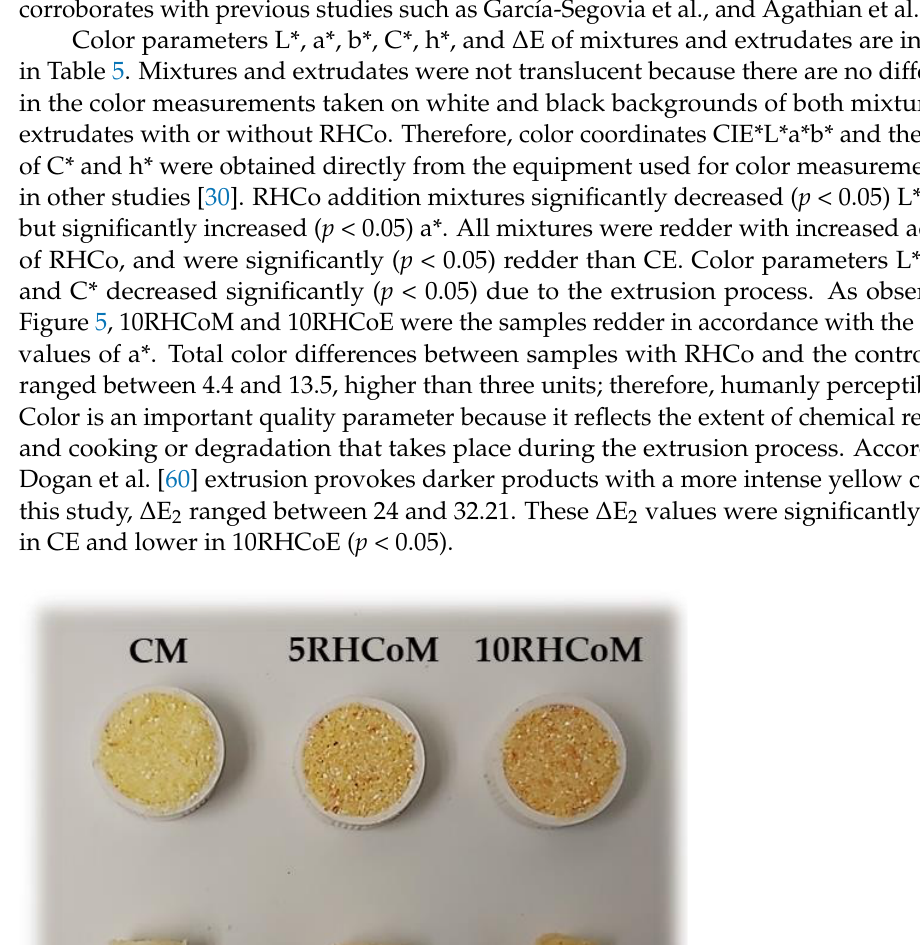
Table 6. Phenolic acids (µg/g dry weight ) of corn mixtures and extrudates. Mean values ± standard deviations. Phenolic Mixtures Extrudates Acid CM